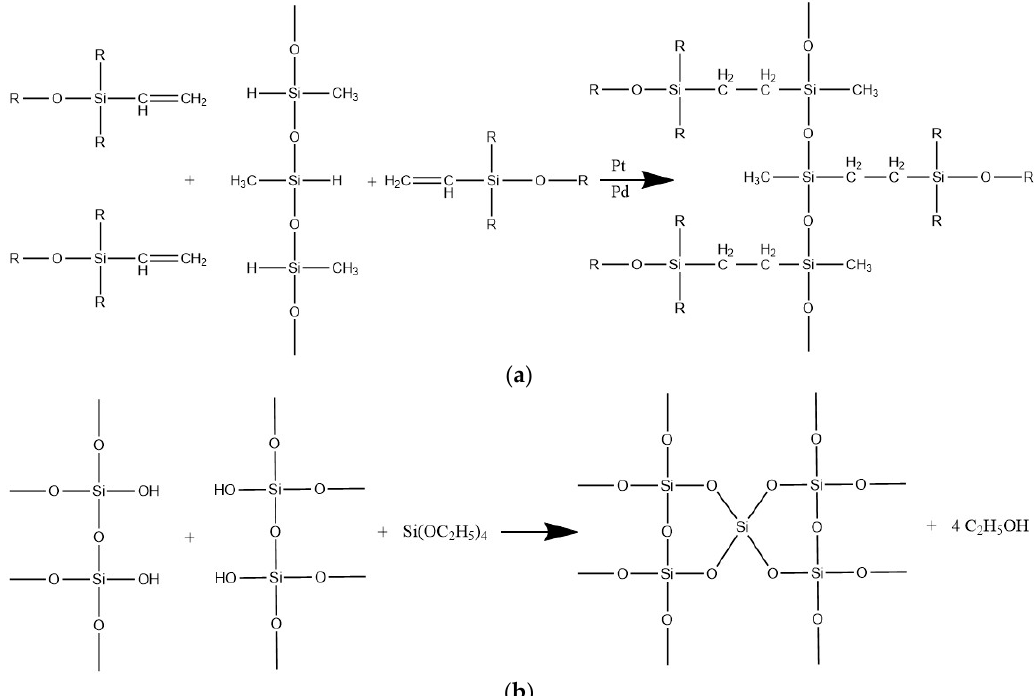
Figure 3. Chemical composition of elastomer matrix ZA 22 ( a ) and N1522 ( b ), poly addition and condensation, respectively.